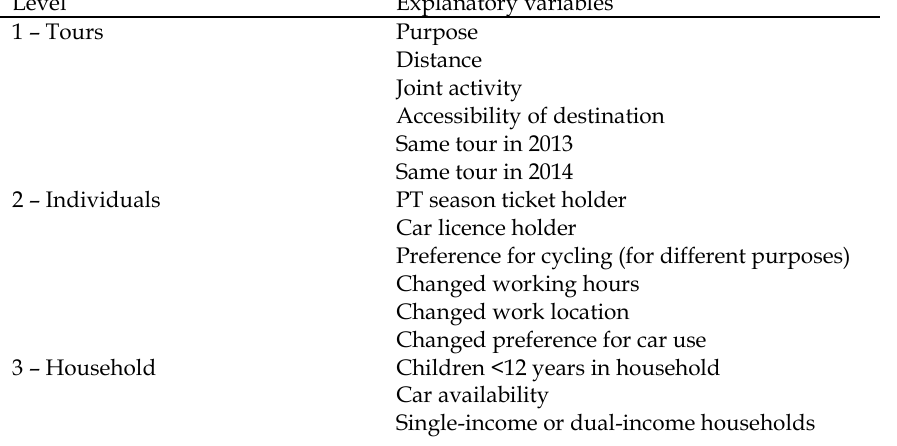
Table 1. Explanatory variables for different